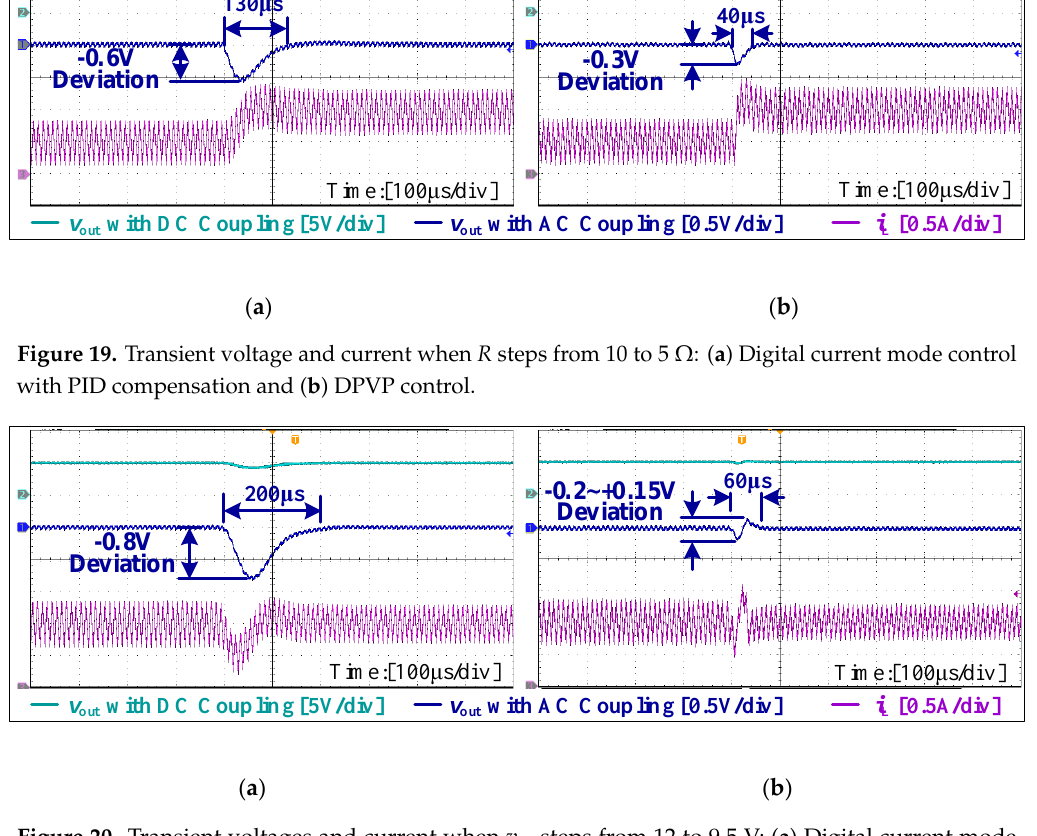
Figure 19. Transient voltage and current when R steps from 10 to 5 Ω: ( a ) Digital current mode control with PID compensation and ( b ) DPVP control.